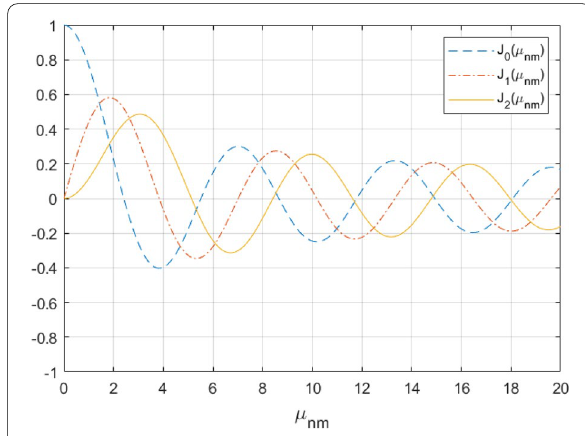
Figure 4 Plot of Bessel functions of first